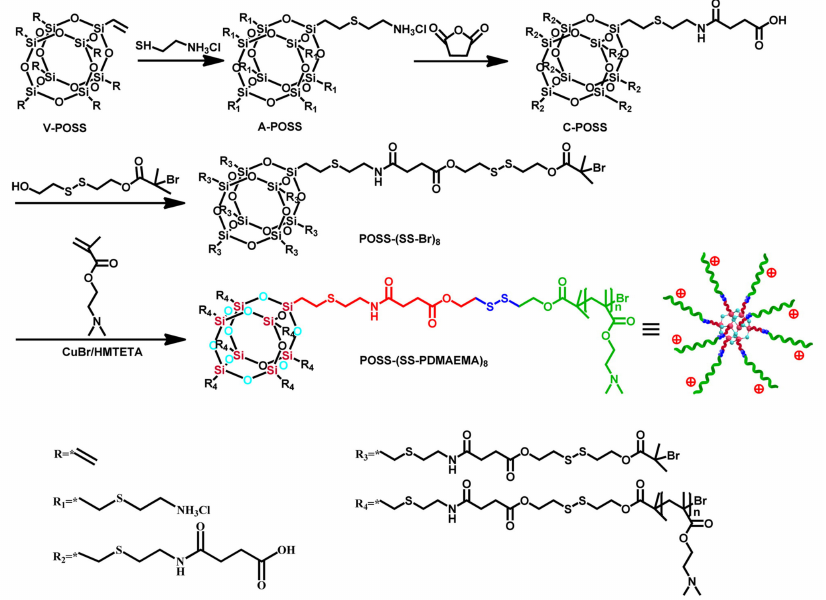
Figure 3. Synthetic processes of bioreducible POSS-based gene vectors via ATRP where * represents the POSS cage. Reprinted with permission from ref. [26]. Copyright 2014 American Chemical